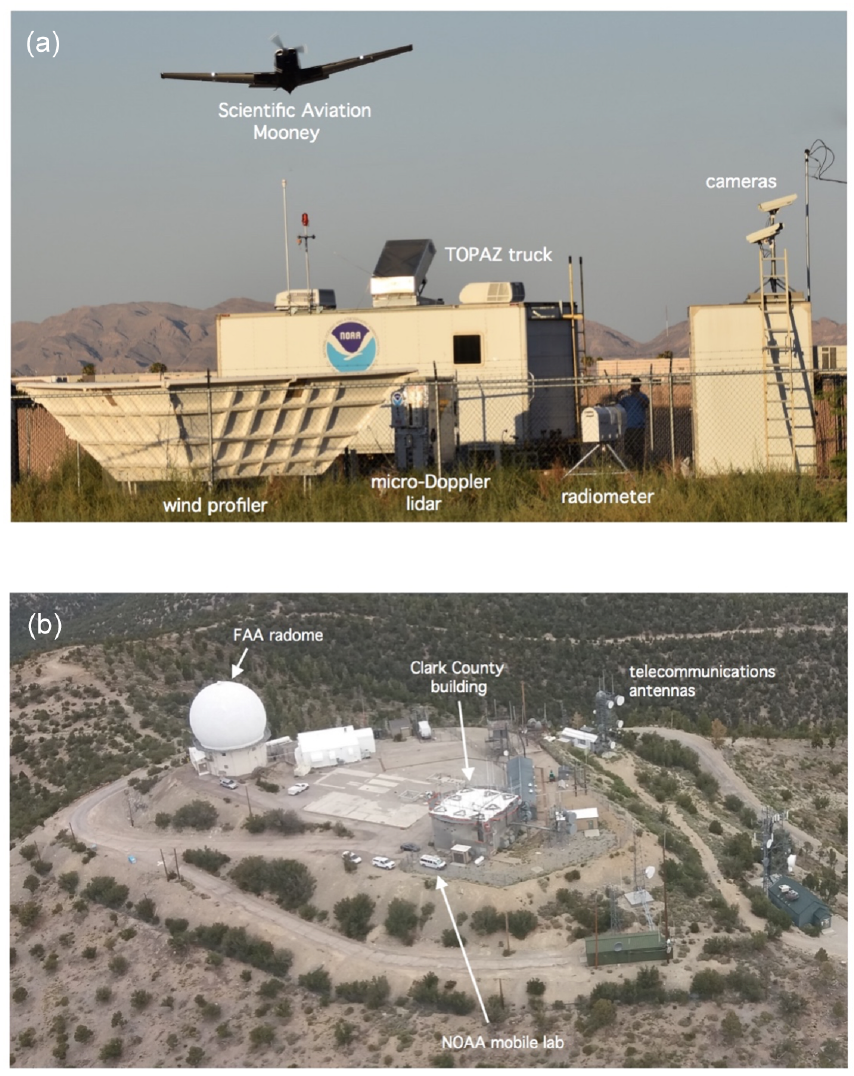
Figure 2. Photographs of the NLVA (a) and AP (b) FAST -LVOS ground sites. The NLVA photograph faces east and the AP photograph northwest. Note the TOPAZ scanning mirror housing near the center of the photograph with the lidar line of sight pointing away from the camera. The view of Angel Peak was taken from the SA Mooney aircraft and shows the NOAA mobile lab parked in the location occupied by the TOPAZ lidar during the 2013 LVOS campaign. Photographs by Andrew Langford (a) and Dani Caputi (b)